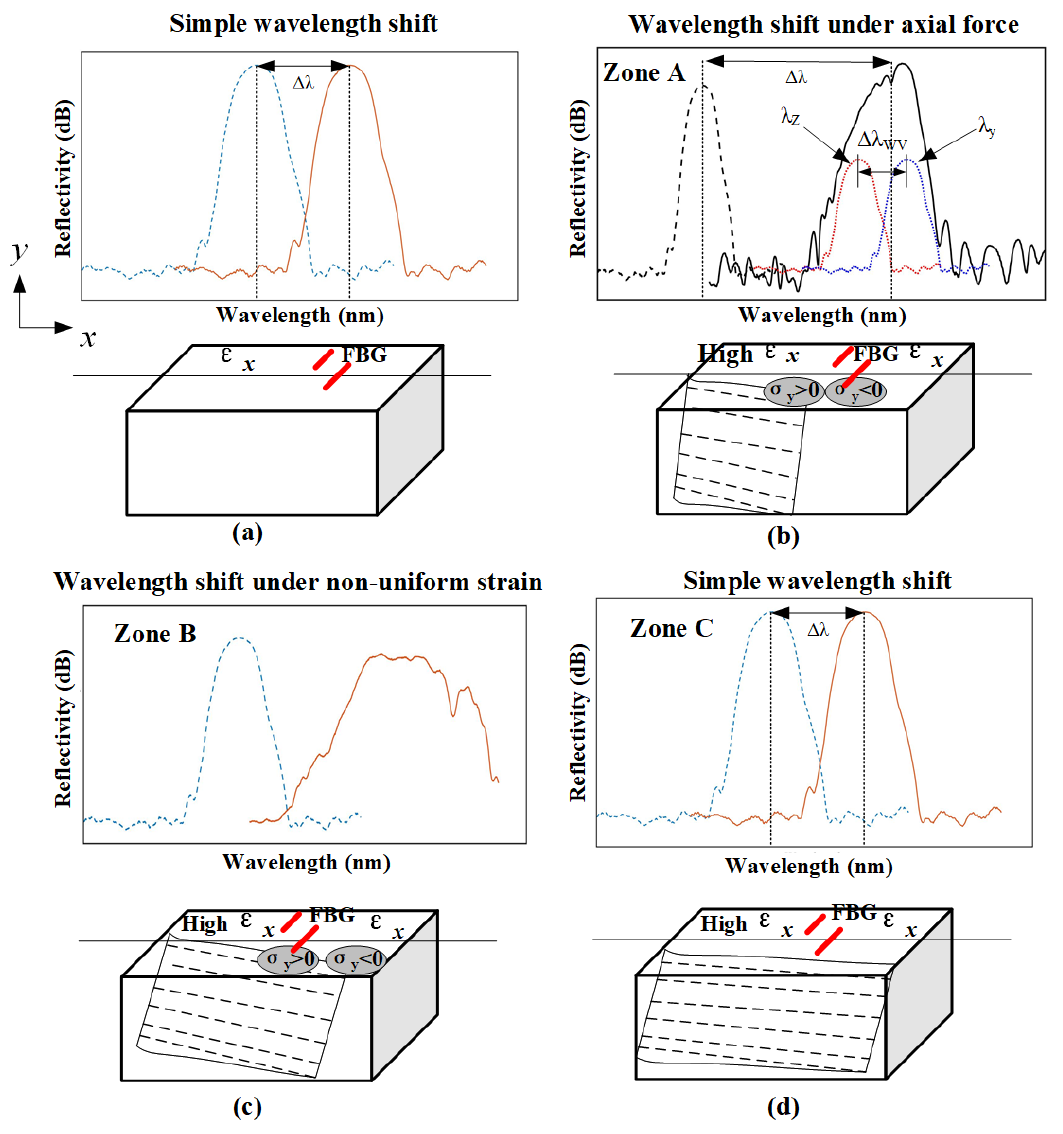
Figure 16. Schematic of the stress field under the crack propagation before cross and after cross the FBG sensors. ( a ) The simple wavelength shift, ( b ) The wavelength shift under axial force, ( c ) The wavelength shift under none-uniform strain, ( d ) The simple wavelength shift.